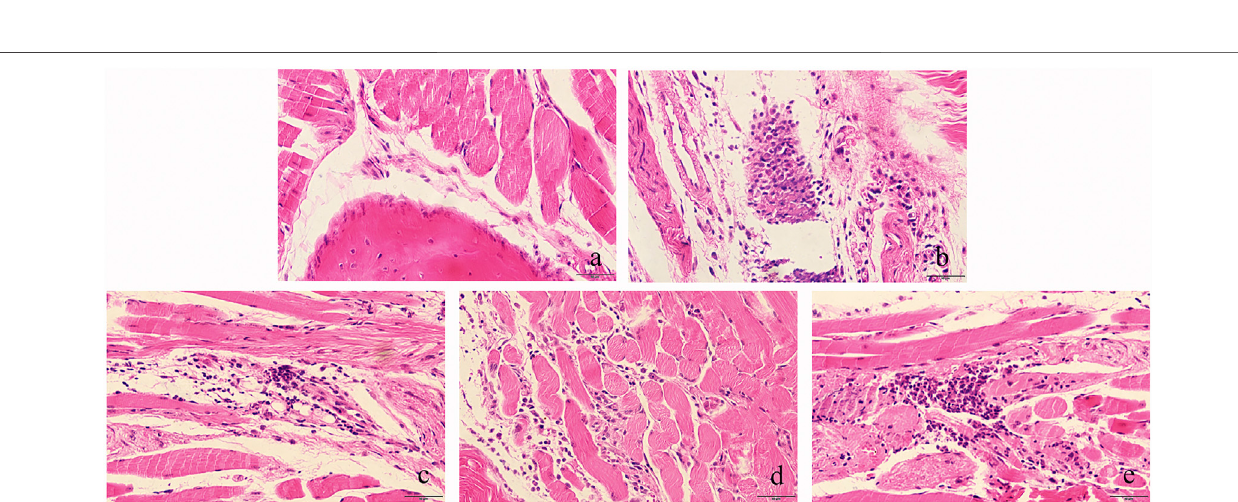
FIGURE12| EffectsofTFandAMonIL-1 β levelinMSU-inducedmice.SupernatantsofthefoottissuehomogenateswereanalyzedforIL-1 β afterTFtreatmentand AM treatment. * p < 0.05 and ** p < 0.01, signi fi cantly different the normal control group; # p < 0.05 and ## p < 0.01, signi fi cantly different the LPS/MSU control group. TF, fl avonoid extract; AM, amento fl avone.